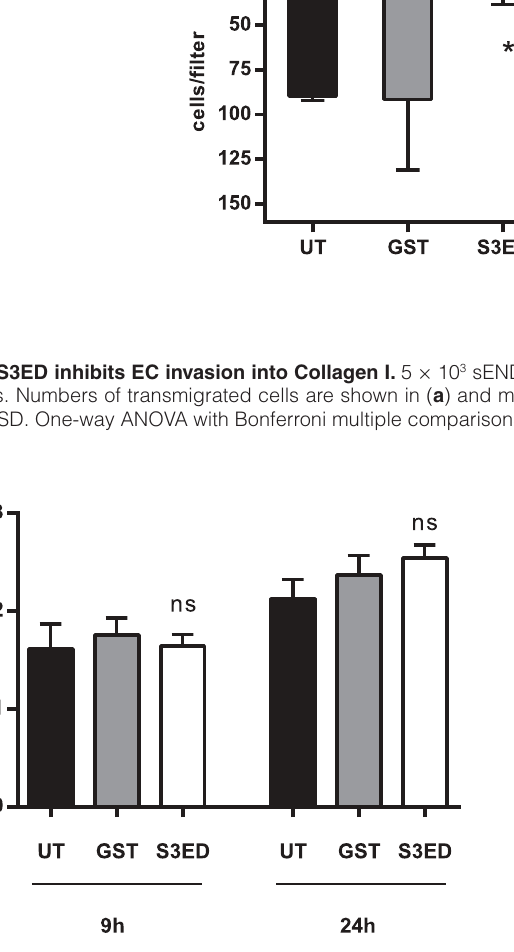
Figure 7. EC proliferation is unaffected by either GST or S3ED. 5 x 10 3 bEND 3.1 cells were incubated in the presence of 0.5 µM of either GST or S3ED. Error bars represent SD. One-way ANOVA with Bonferroni multiple comparisons was used to compare S3ED to relative UT control showing no statistically significant difference between the two at after 9 and 24